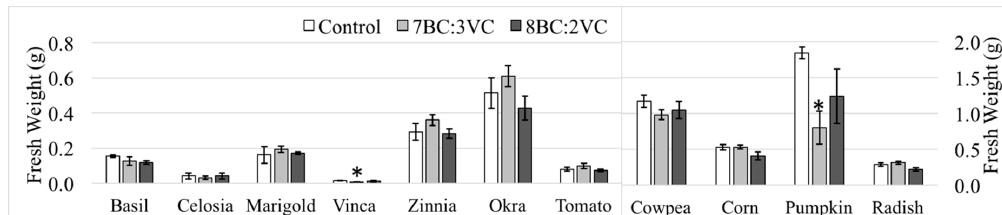
Figure 4. Fresh weight (mean ± standard error) of the seedlings in commercial propagation mix (control), 70% biochar:30% vermicompost (7BC:3VC, by volume), or 8BC:2VC in Experiment 1. The asterisks indicate differences from the control using Dunnett’s test at p < 0.05 ( n = 4).